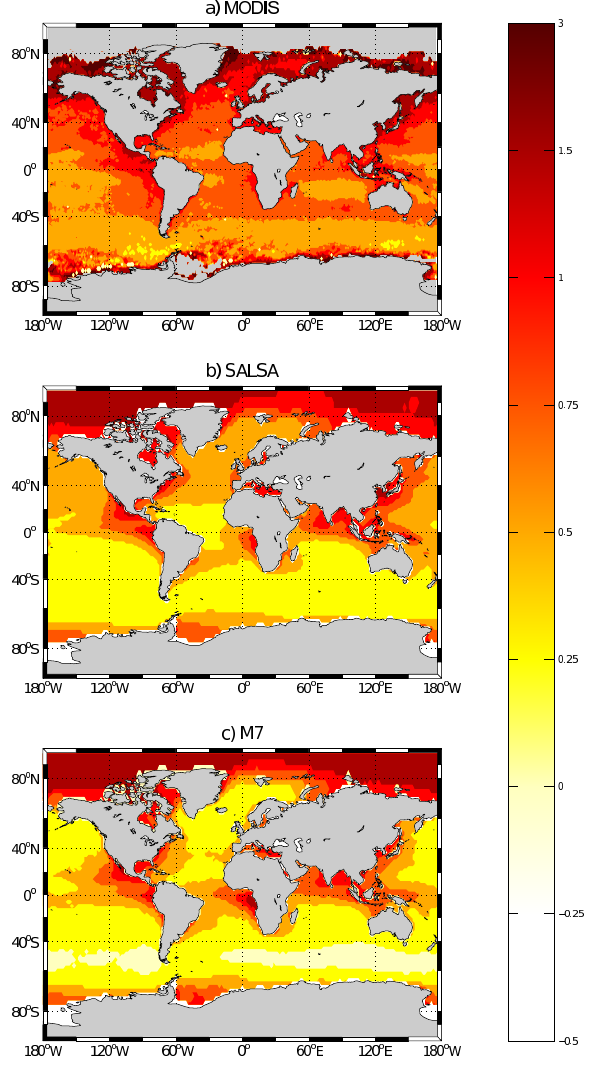
Fig. 11. Simulated and satellite retrieved annual mean ˚Angstr¨om exponent of MODIS (550/865nm), SALSA (550nm/825nm) and M7 (550nm/825nm) for year 2008. Gray areas either have no data or have been omitted.